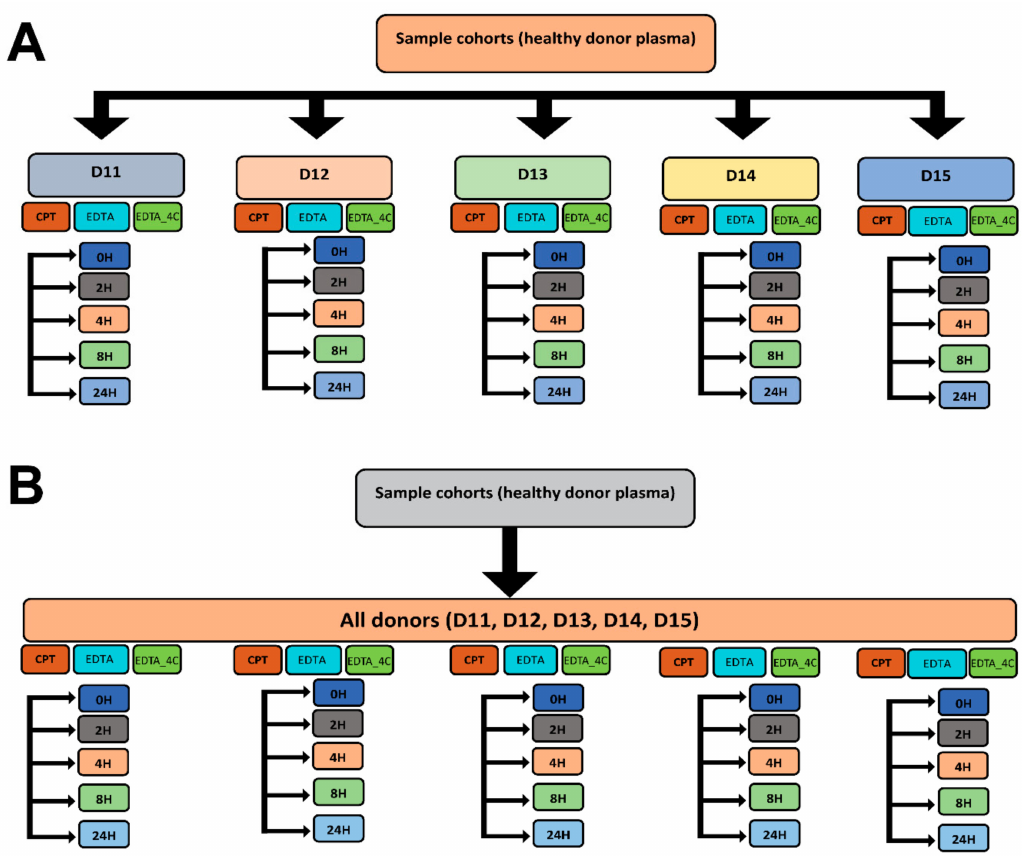
Figure 1. Statistical analysis strategies for untargeted lipidomics. ( A ) donor-matched strategy and ( B ) donor-unmatched strategy. The study comprises five donors (D11, D12, D13, D14, and D15), two di ff erent anticoagulants sodium citrate and potassium ethylenediaminetetraacetic acid represented as CPT and EDTA respectively, two di ff erent temperatures (4 ◦ C and room temperature) and five di ff erent storage times before processing (0H, 2H, 4H, 8H, and 24H). The 0H EDTA samples represent the baseline for both EDTA containing samples at 4 ◦ C and room